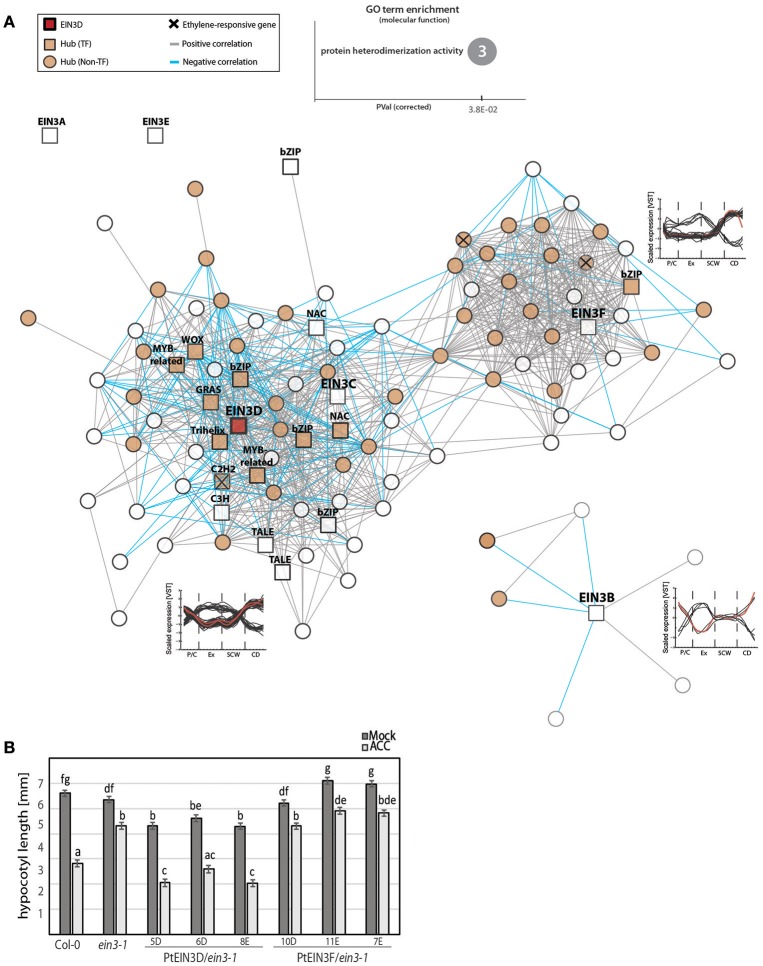
EIN3 isoforms are co-expressed with TFs involved in transcriptional regulation and secondary cell wall biosynthesis. (A) Co-expression gene modules (threshold of five) of EIN3B, EIN3C, EIN3D, and EIN3F. TFs are shown as squares, while all non-TFs are represented by circles. Hubs are indicated by orange filling. Positive correlation between two genes is represented by gray lines (edges), negative correlations are indicated by blue edges. Ethylene-responsive genes shown in Figure 2C are marked with a cross (see Supplementary Table S5). Line graphs show scaled expression profiles of genes in each modules during wood formation, with red lines depicting the expression pattern of each EIN3 isoform. GO term enrichment was performed with Arabidopsis homologs. Number in the circle indicates number of genes belonging to this GO term found among all 87 EIN3 co-expressed genes. (B) Estimate of hypocotyl length [in mm] with standard error, calculated using a linear effect model. Vernalized seeds were germinated in the dark for 72 h in the presence/absence of 10 μM ACC. Hypocotyl length was determined from 29 to 44 biological replicates (depending on genotype, treatment and experiment) obtained from two independent experiments. Raw data, including number of biological replicates per line, treatment and experiment can be extracted from Supplementary Table S8.